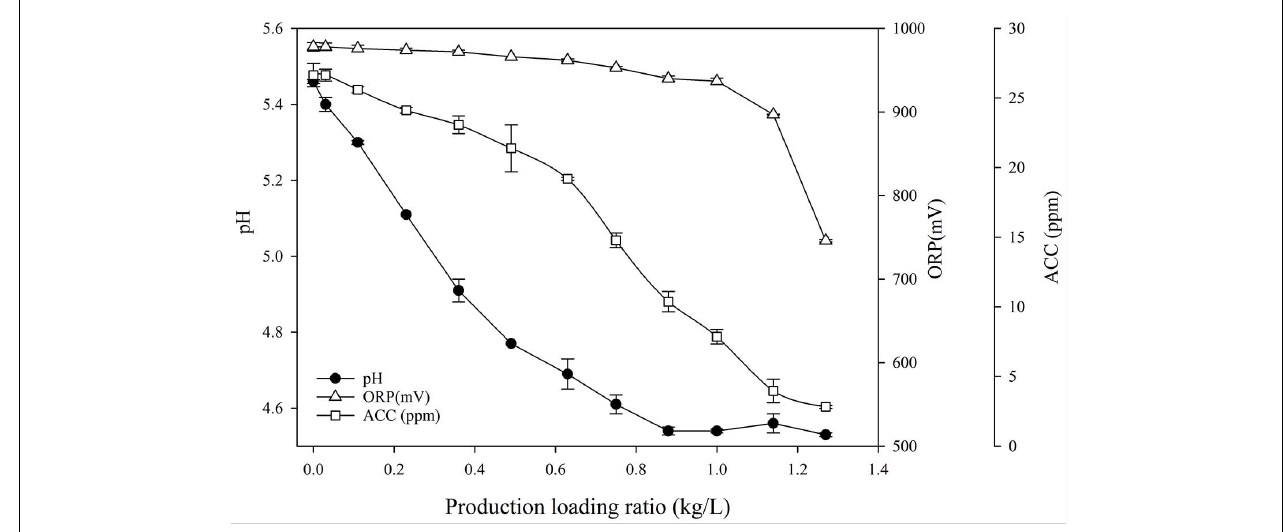
FIGURE 2 | Changes in the pH, ORP, and ACC of SAEW sampled after disinfection and washing fresh